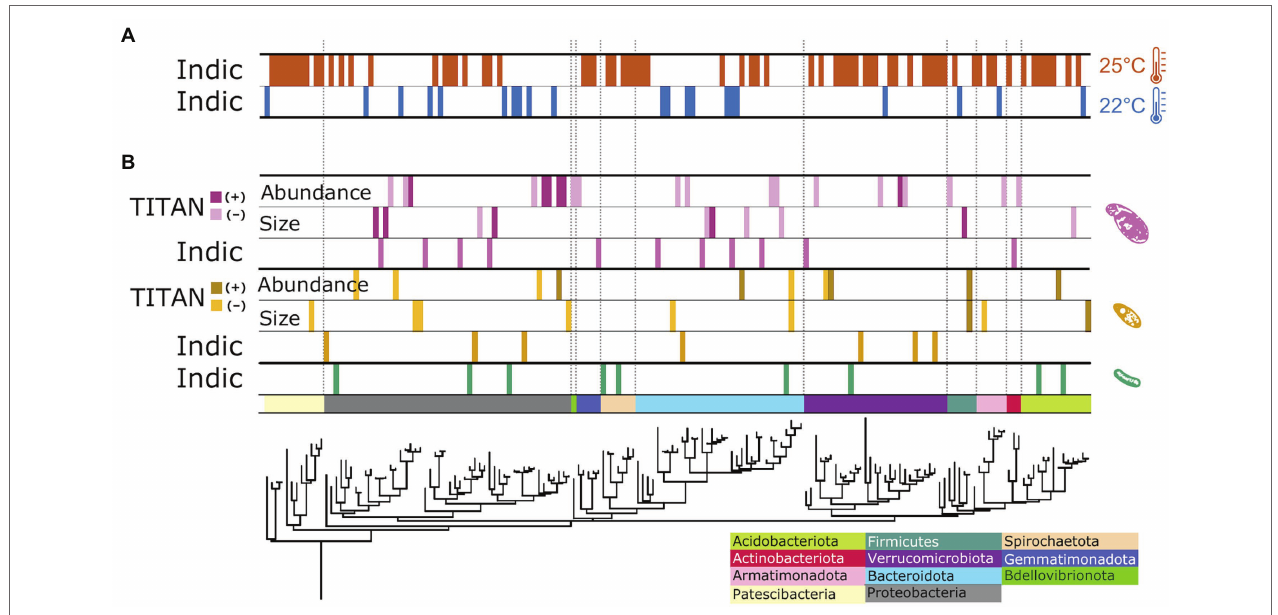
FIGURE 4 | Phylogenetic distribution of treatment impacts on individual bacterial ASVs. Responder ASVs showing consistent change in relative abundance to temperature (A) and protist (B) treatments. Data strips labeled, “Indic,” represent ASVs positively correlated with a particular temperature treatment level, generated from multi-level pattern analysis output; data strips labeled, “TITAN,” show responding ASVs to changes in specific protist species’ traits, analyzed with direct gradient